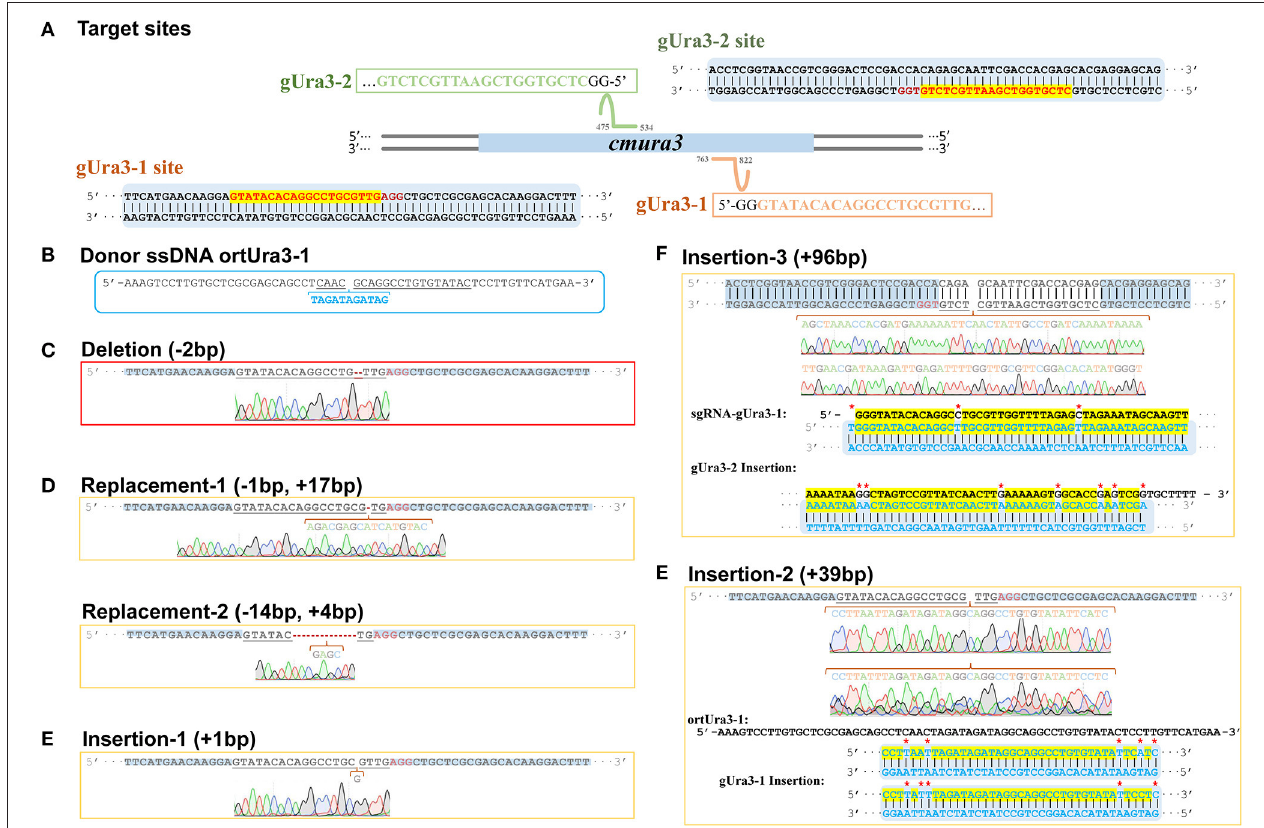
FIGURE 5 | Sequence design and alignment diagrams for editing cmura3 by CRISPR-Cas9 in vivo . (A) The localized sites and target sequences of sgRNA. (Apostrophe in the box represents the sgRNA scaffold sequence). (B) The sequence of donor ssDNA ortUra3-1. (The target sgRNA site was underlined; the inserted sequence was marked blue and listed separately). (C) The sequence and sequencing chromatogram for gUra3-1 deletion mutation. (D) The sequences and sequencing chromatograms for gUra3-1 replacement mutation. (E) The sequences and sequencing chromatograms for gUra3-1 insertion mutation and the alignments for the insertions. (F) The sequence and sequencing chromatogram for the gUra3-2 inserted mutation and alignment for the